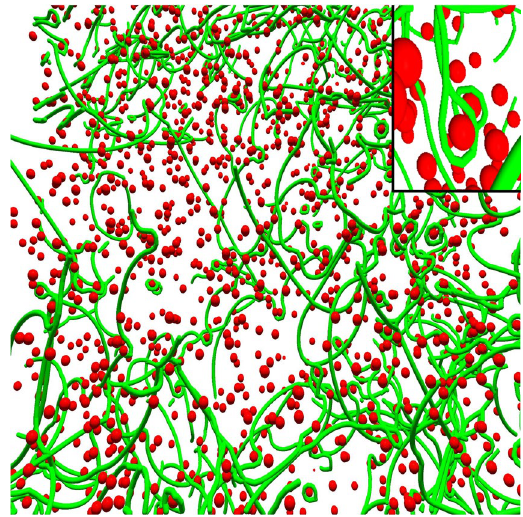
Figure 3. Close-up look at the 3D structure of a dislocation system with strong precipitates at a strain of ε = 0.63%. Dislocations (green lines) evolve into a complex network where they pin to each other forming junctions. Dislocations that have bypassed precipitates (red spheres) have left Orowan loops around some of the obstacles. In the inset there is an example of a twisted noose where the edge arms of the loops are on different glide planes and thus cannot annihilate each